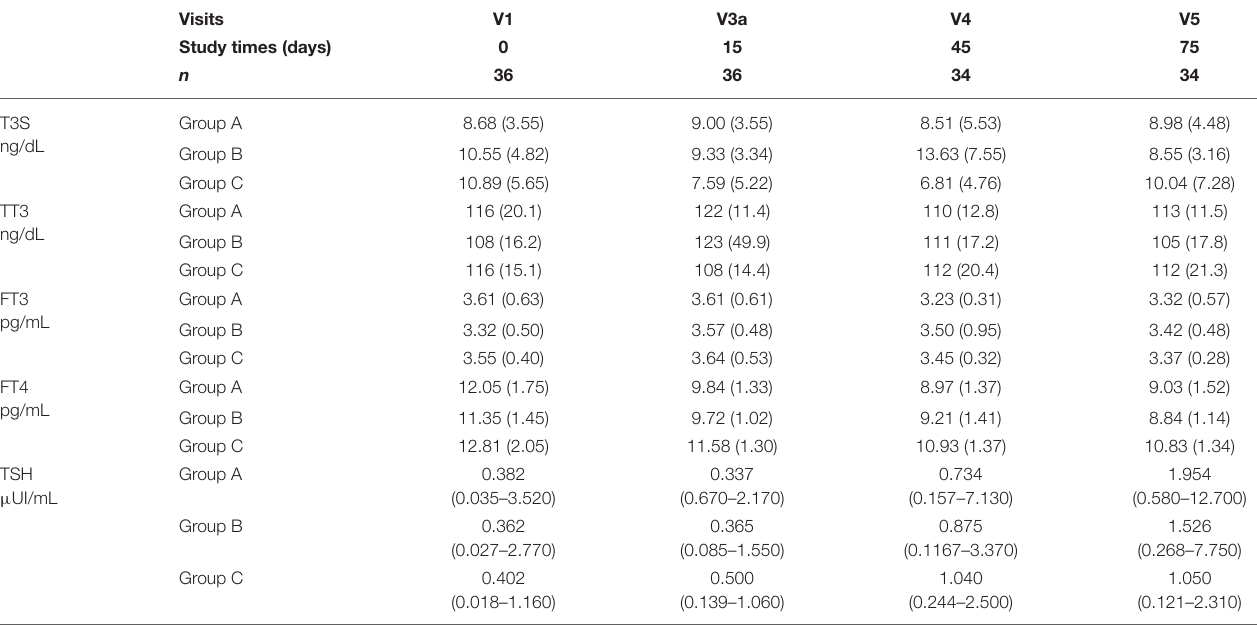
TABLE 2 | Serum levels of T3S, TT3, FT3, FT4 (mean and SD ), and TSH (geometric mean and min-max values) in various groups throughout the